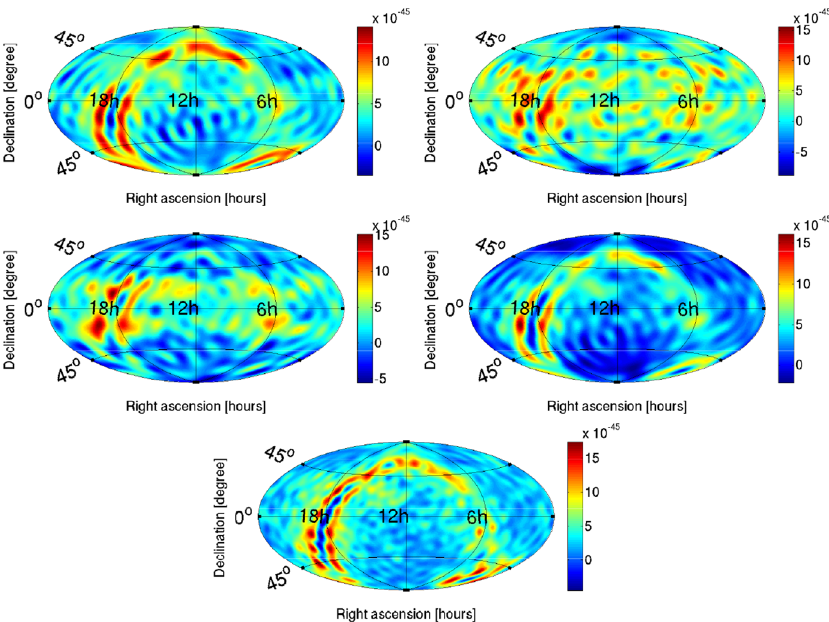
Fig.51 Resultsofsphericalharmonicdecompositionanalysesperformedusingdifferentdetectorpairsand a multibaseline detector network. The simulated anisotropic power distribution is shown in the bottom plot. Top row clean maps for the Hanford–Livingston and Hanford–Virgo detector pairs. Second row same as the top row , but for the Livingston–Virgo detector pair and for the Hanford–Livingston–Virgo multibaseline detector network. For all maps l max = 20. Image reproduced with permission from Thrane et al. (2009), copyright by